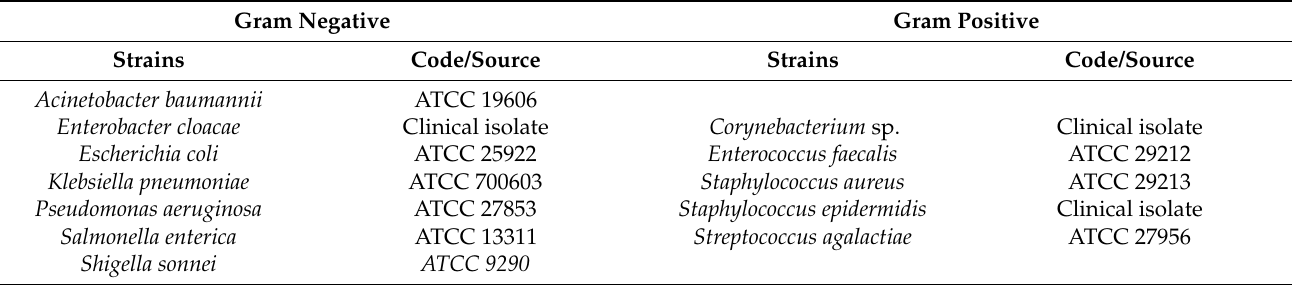
Table 2. The strains used during the antibacterial